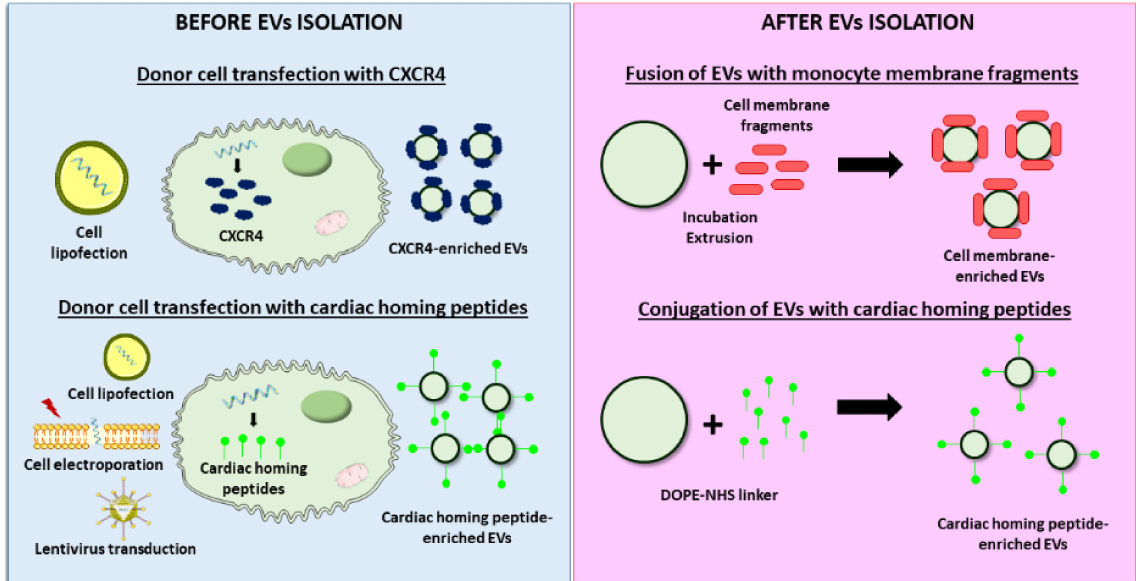
Figure 4. Examples of EVs surface functionalization strategies to improve cardiac targeting. Modification of EV surface can be performed before or after isolation. Regarding the first approach, donor cells are transfected/transduced to overexpress specific molecules that target cardiac epitopes on the released EV’s surface. On the other hand, different techniques can be used to incorporate cardiac-targeting molecules on the EV’s surface after isolation, such as fusion of EVs with monocyte membrane fragments by incubation/extrusion or conjugation of cardiac homing peptides via a dioleoylphosphatidylethanolamine N -hydroxysuccinimide (DOPE-NHS)